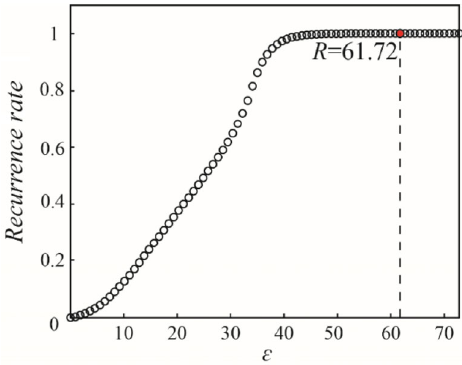
Fig. 6 Sketch map of computing enclosing radius R based on RR